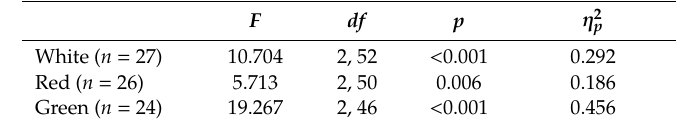
Table 7. Statistics for the ANOVAs conducted to evaluate the effect of content type with respect to content color. Table 8. Post-hoc comparisons analyzing the content type.